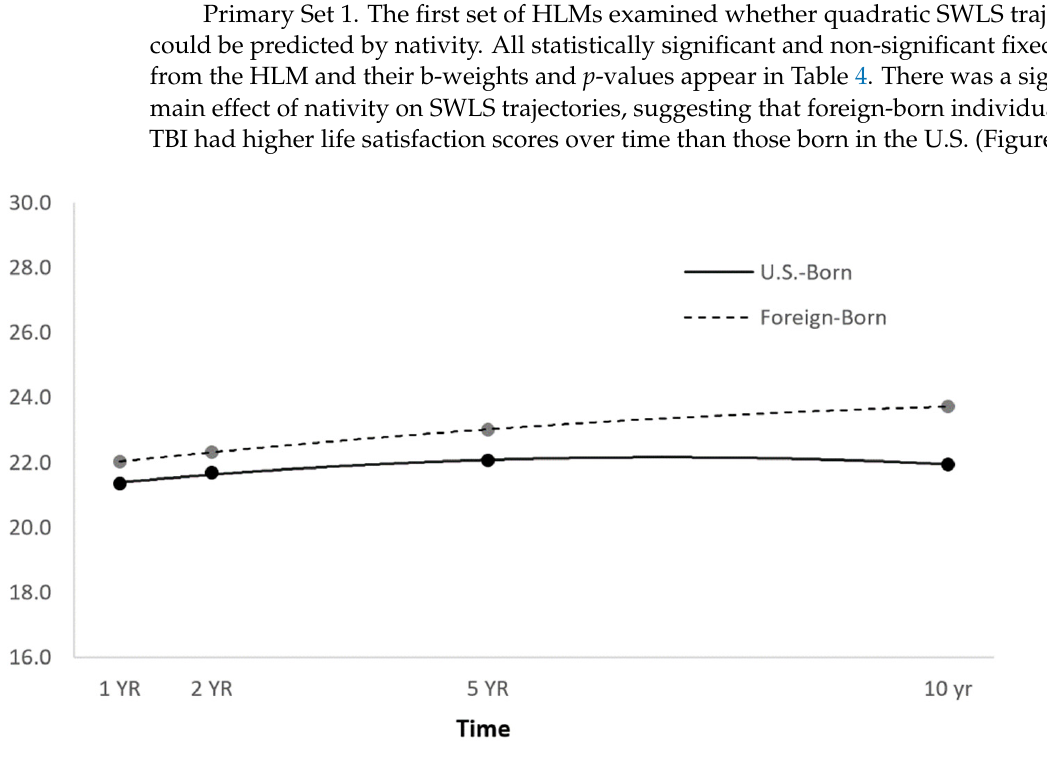
Figure 1. Main effect of nativity on SWLS trajectories.